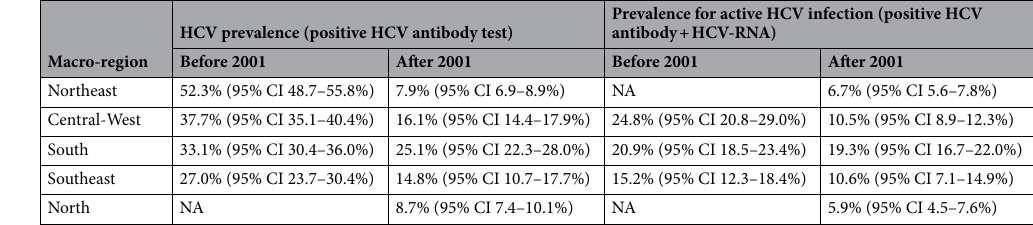
Table 3. Results of binomial logistic models fitted to data from studies implemented before and after 2001 for HCV prevalence (positive HCV antibody test) and prevalence of active HCV infection (positive HCV antibody + HCV-RNA). NA: No estimates were available, since no study was implemented in that time